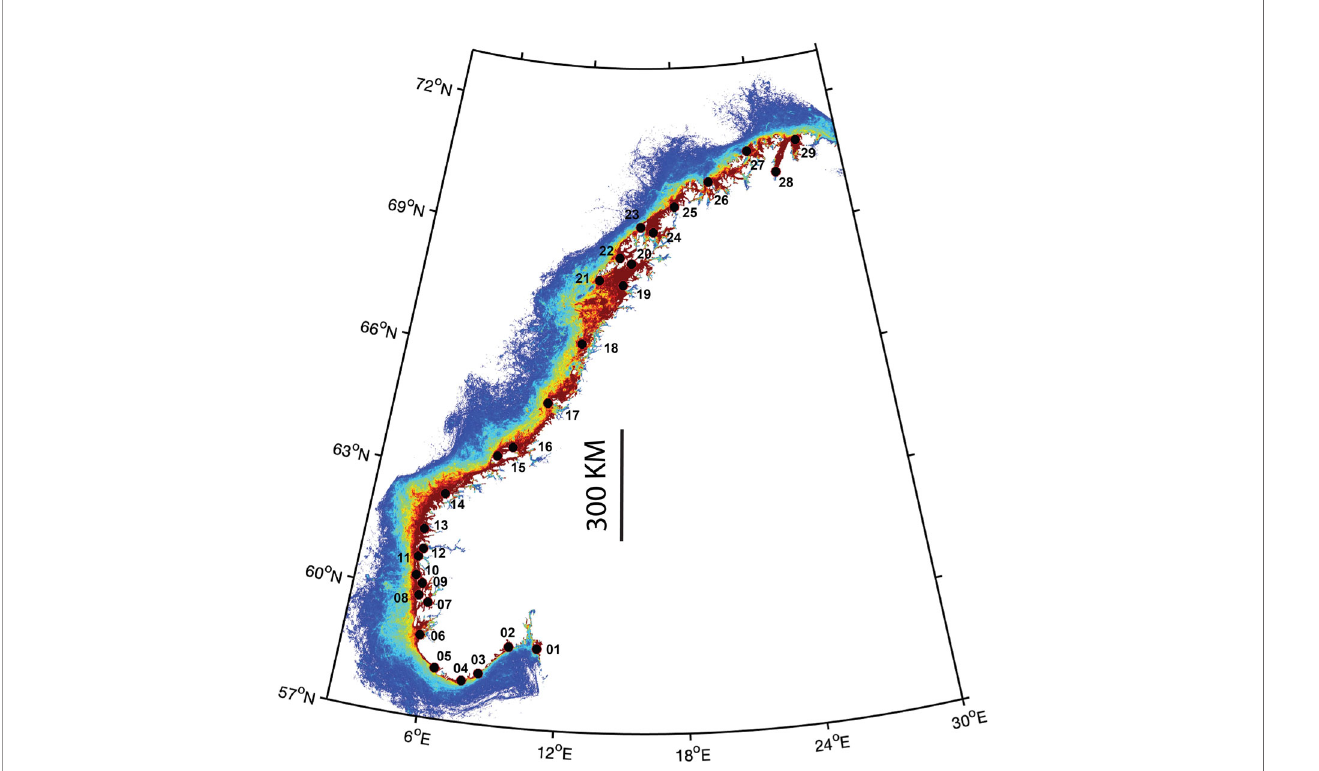
FIGURE 5 | Aggregated particle concentration from all 29 release locations along the coast for the period October 2018 – January 2019. Dark blue color represents low aggregation and red colour high